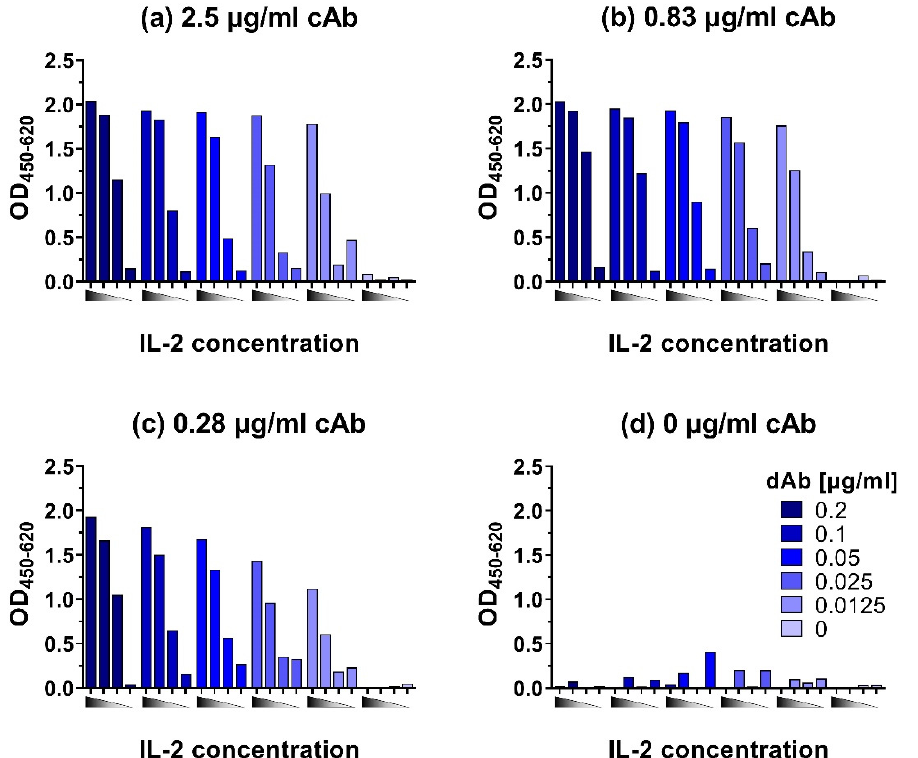
Figure 3. Checkerboard titration of capture antibody (cAb) at ( a ) 2.5 µg/mL, ( b ) 0.83 µg/mL, ( c ) 0.28 µg/mL, and ( d ) 0 µg/mL and titration of detection antibody ( dAb) with 10,000, 1000, 100, and 0 pg/mL recombinant IL-2 from left to right represented by . Titration was performed to check for the best combination of antibodies in a broad range of cytokine concentrations.